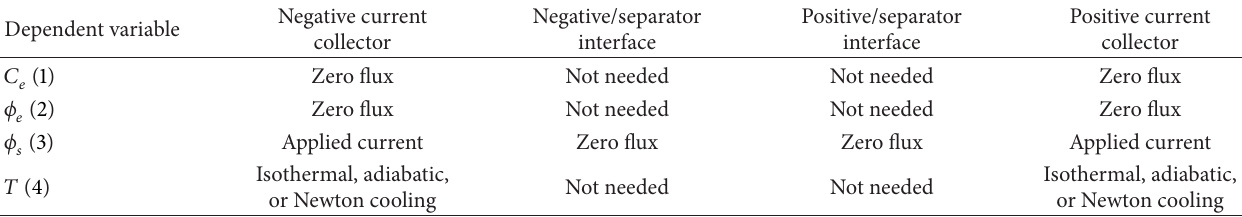
Table 1: Summary of boundary conditions required for the solution of the governing conservation